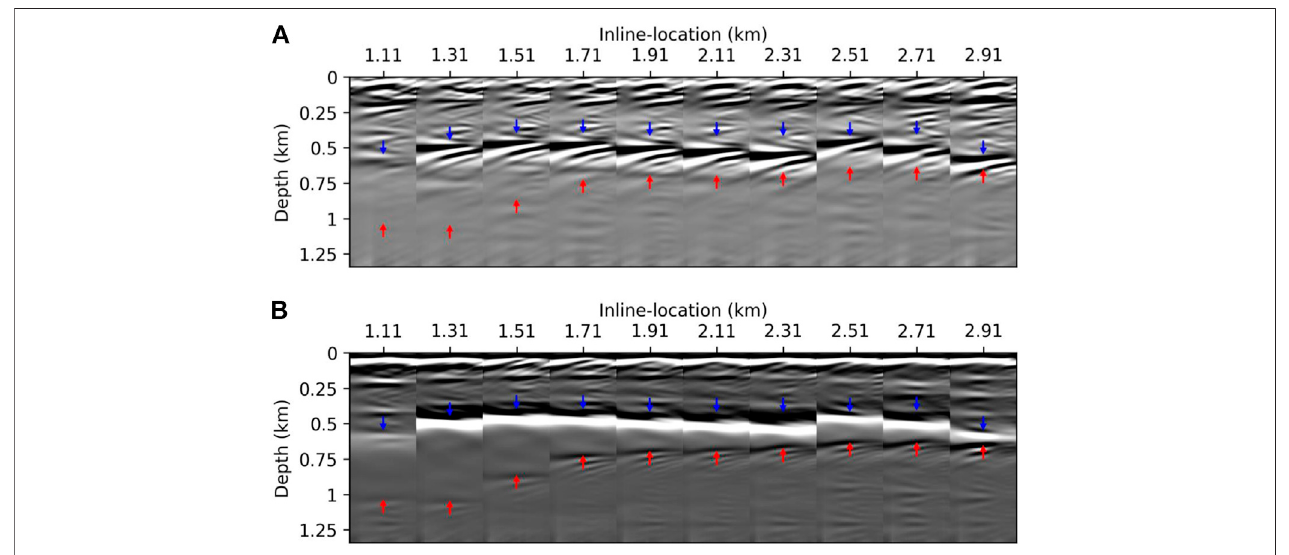
FIGURE 9 | Comparisons of ten FDCIGs spliced between (A) linearly increasing velocity model and (B) smoothed true velocity model. Each FDCIG has frequency range from 3 to 40 Hz. Blue and red arrows indicate the location of the actual salt top and bottom, respectively.